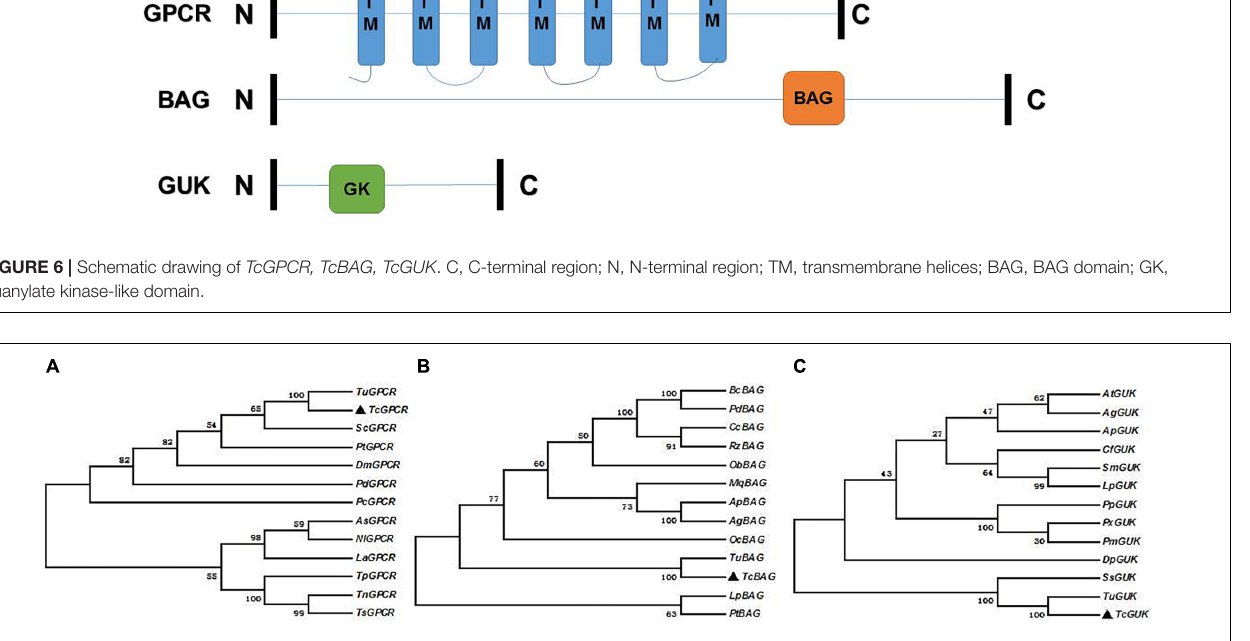
FIGURE 7 | Phylogenic analysis of TcGPCRs, TcBAGs and TcGUKs , respectively. Maximum likelihood tree constructed by MEGA 5.0. Phylogeny testing was conducted via the bootstrap method with 1000 replications. A , B , and C were TcGPCRs, TcBAGs, and TcGUKs , respectively.